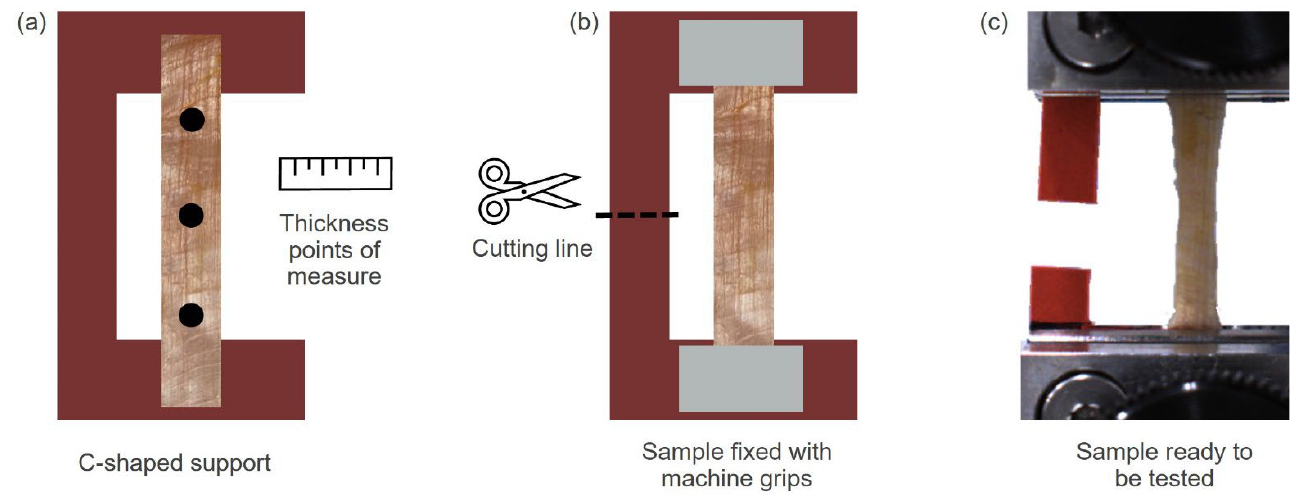
Figure 2. Sample preparation for mechanical testing. ( a ) Rectangular samples were positioned on rigid C-shaped supports and fixed with commercial superglue. Thickness was measured in at least three points (black dots) along the sample with a manual caliper. ( b ) Once the support with the sample was anchored to the machine grips, the support was cut, in order to not affect the mechanical test. ( c ) The sample is ready for the uniaxial test.